Question: Write a caption explaining this figure to a reader.
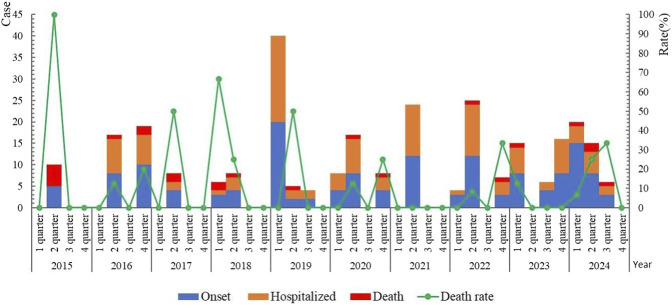
Answer: Joinpoint regression analysis of Gelsemium poisoning in Guangxi, 2015–2024.